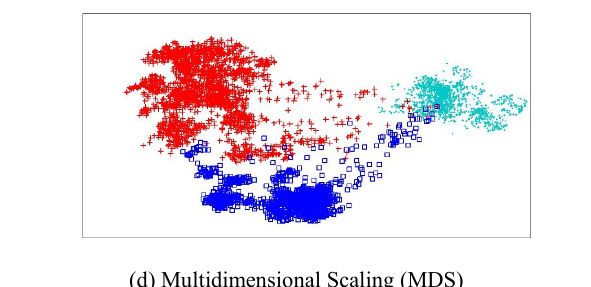
Figure 8 . PPCA (Probabilistic Principal Component